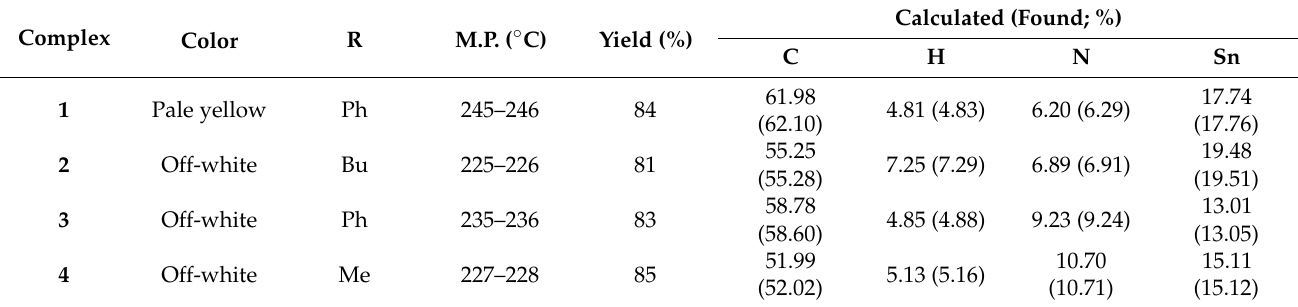
Table 1. Synthesis and some physical properties data for 1 – 4